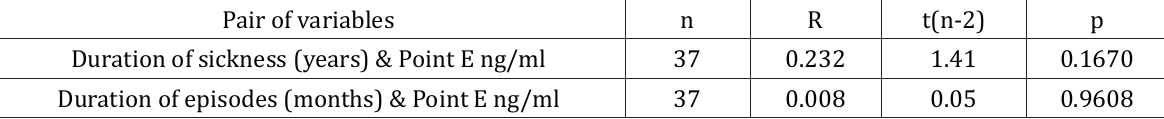
Table 17. Spearman Rank correlations between duration of sickness and the duration of episodes and the concentration of MMP-9.